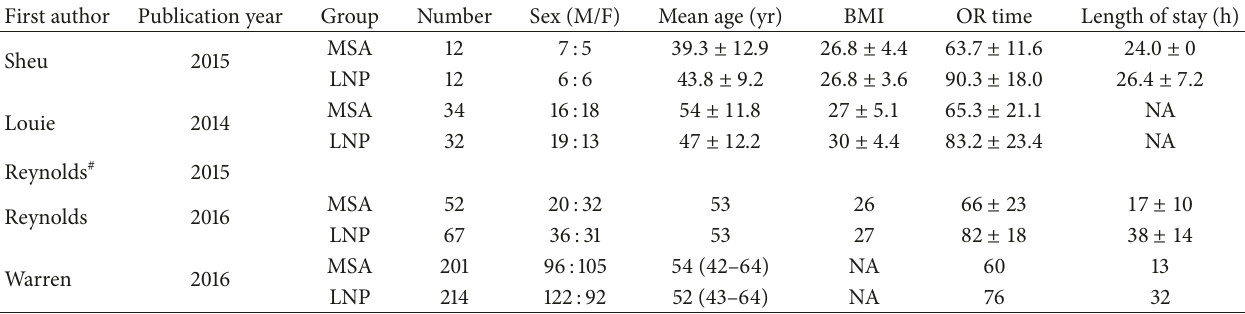
Table 1: Baseline characteristics of studies included in the